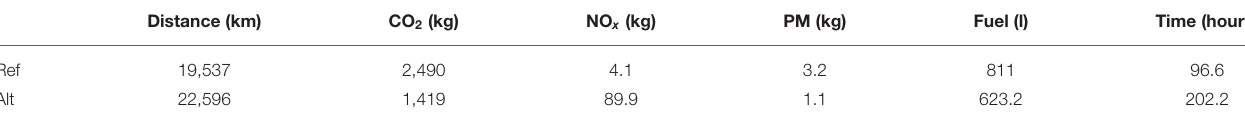
TABLE 8 | The cumulative tailpipe (direct) figures of the reference and alternative scenarios for the workshops. Distance (km) CO 2 (kg) NO x (kg) PM